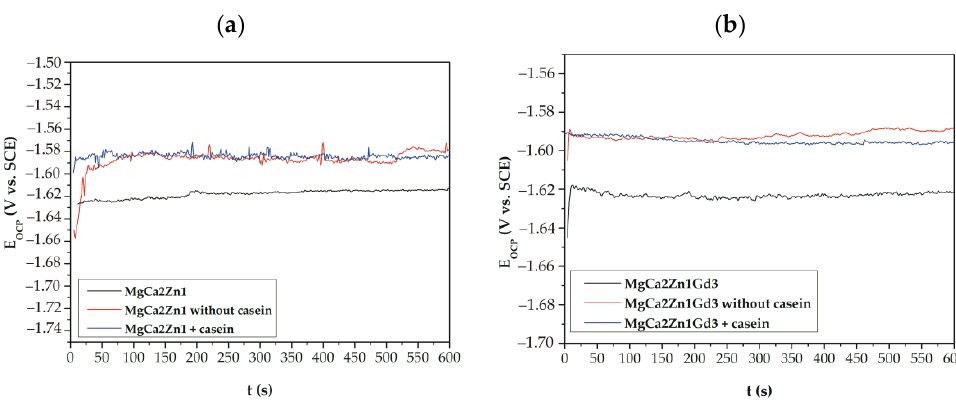
Figure 8. The E OCP changes as a function of immersion time for studied casein and casein-free coatings applied to: ( a ) MgCa2Zn1 and ( b ) MgCa2Zn1Gd3 alloys in Ringer solution at 37 °C.